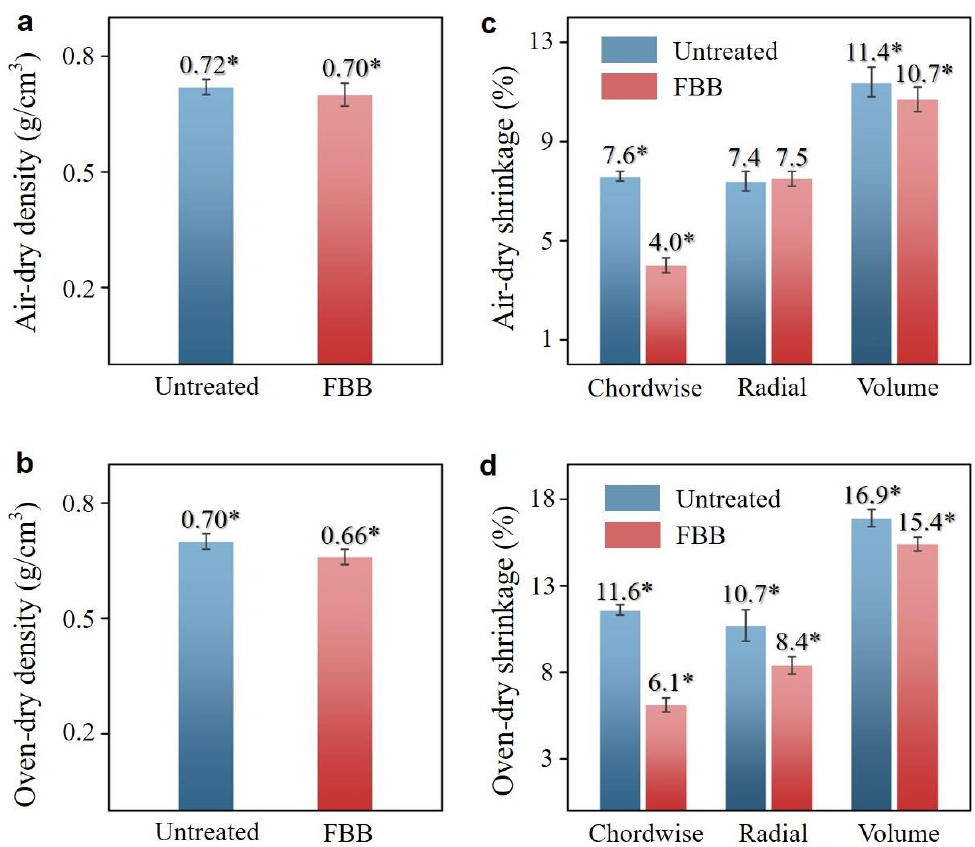
Figure 4. Comparison of ( a ) air-dry density, ( b ) oven-dry density, ( c ) air-dry shrinkage and ( d ) oven- dry shrinkage of bamboo before and after flattening modification. The data in the graph are average values and the error bars represent standard deviations. Values followed by “ * ” indicate that the p -value of the t -test is less than 0.05, and significant differences appear between untreated and FBB data, while unmarked values indicate no significant differences.